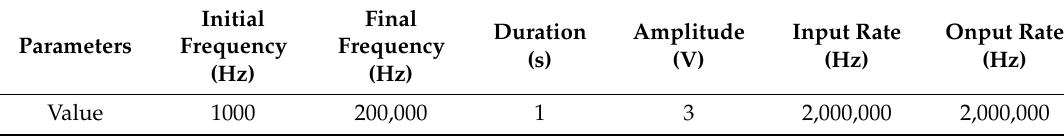
Table 3. The detailed parameters of the swept sine wave signal.